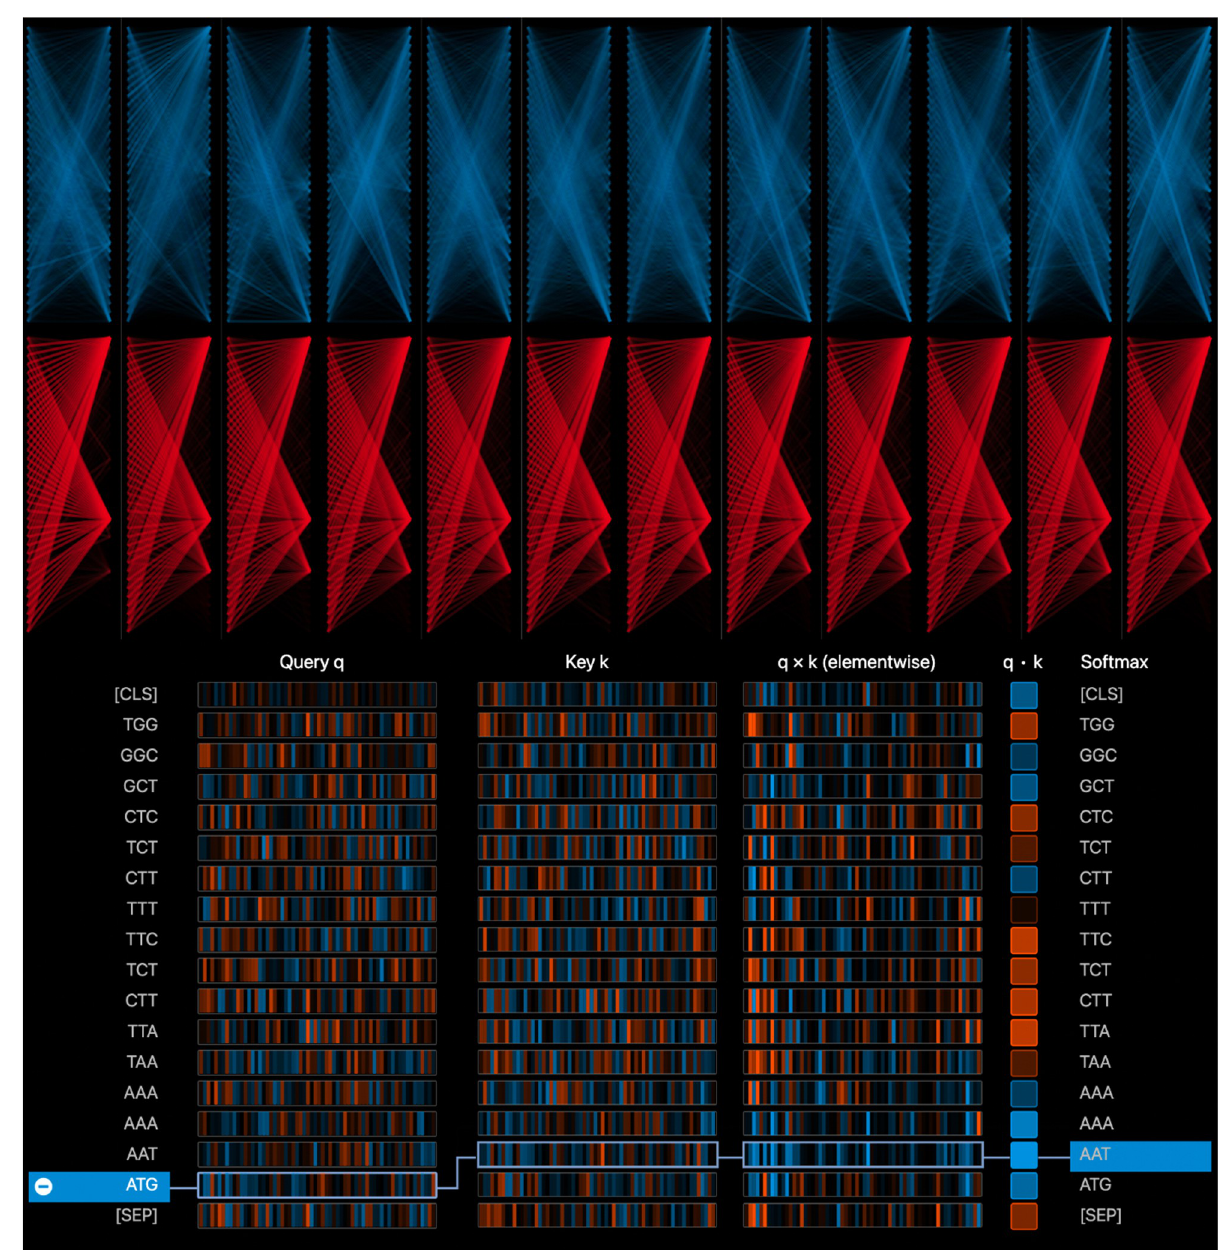
Fig 7. Top half shows a bird’s eye view of the attention distribution of the different attention heads in two different layers of EnhancerBERT, the columns represent attention heads of each EnhancerBERT layer, and rows represent layers of EnhancerBERT. With iterating of the EnhancerBERT layer, the attention scores of each attention head gradually concentrate in some key regions of input enhancer sequence; Bottom half visualizes the process of attention score calculation, where first and second columns represent Query vector and Key vector, respectively. The framed up vectors show the two most relevant tokens in the enhancer